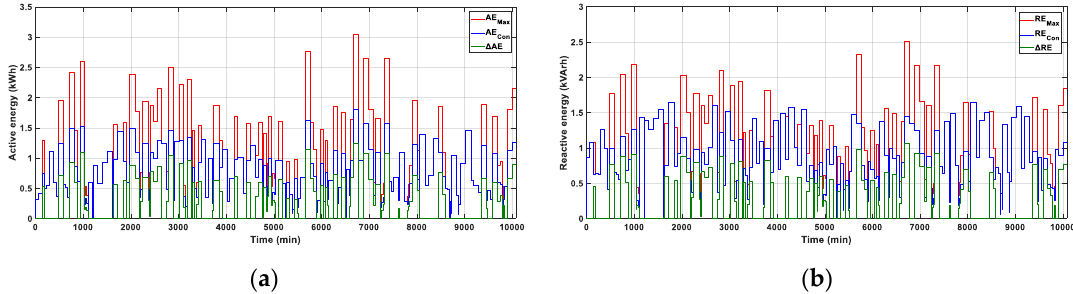
Figure 14. Weekly energy of IM 1.5 kW (IMEMSL #2): ( a ) Active energy; ( b ) Reactive energy.